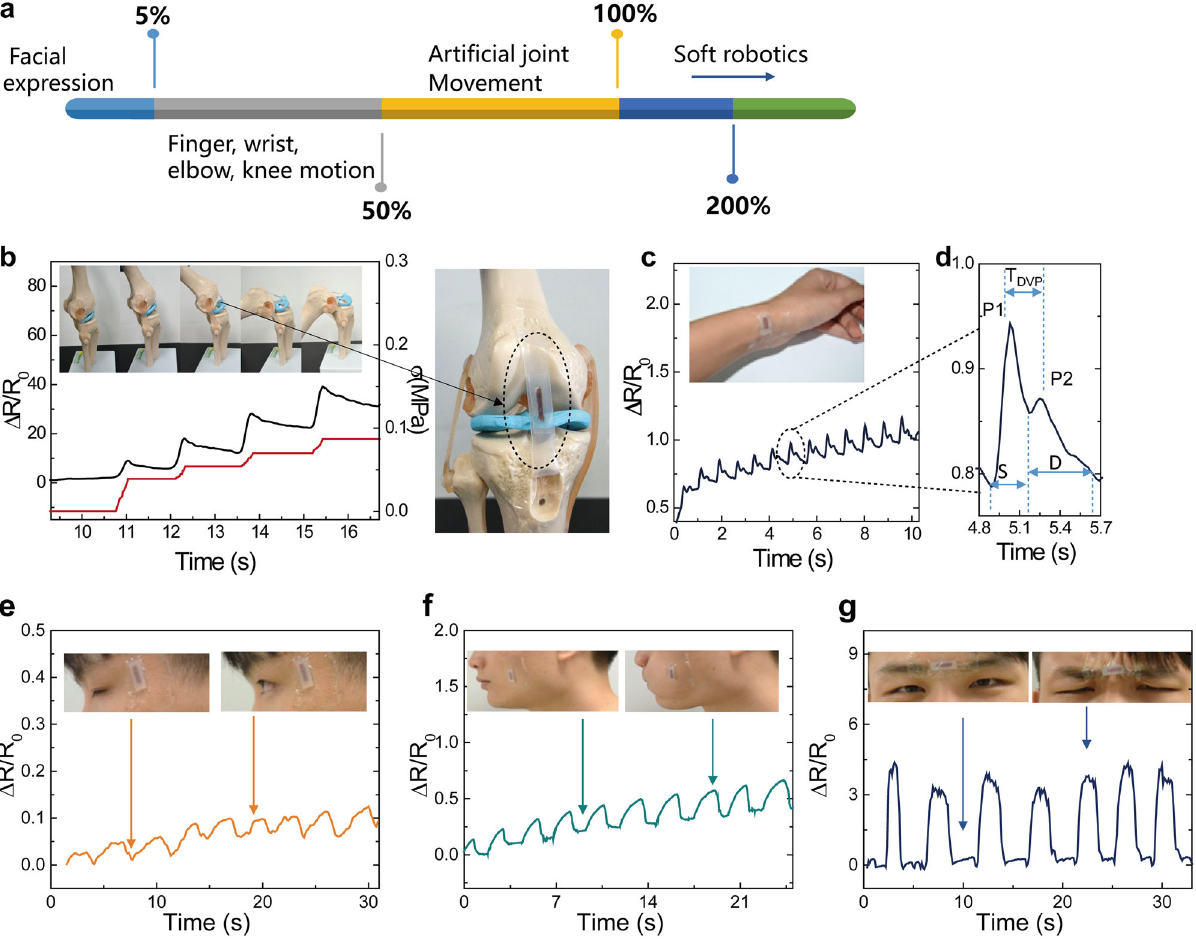
Fig. 5 a Illustration of the human activity and the approximate range of strain scales. b Relative resistance responses of the NMH strain sensor for detecting the bending state of a skeleton knee model (black), and the tensile strength of the NMH strain sensor under different deformations (red). c – g Detection of small-scale human body deformations by the NMH strain sensor: c Relative change in the resistance of the sensor monitoring the pulse on a human wrist. ( d ) A typical pulse waveform is shown on the right. e Eye blinking, f cheek movement, and g